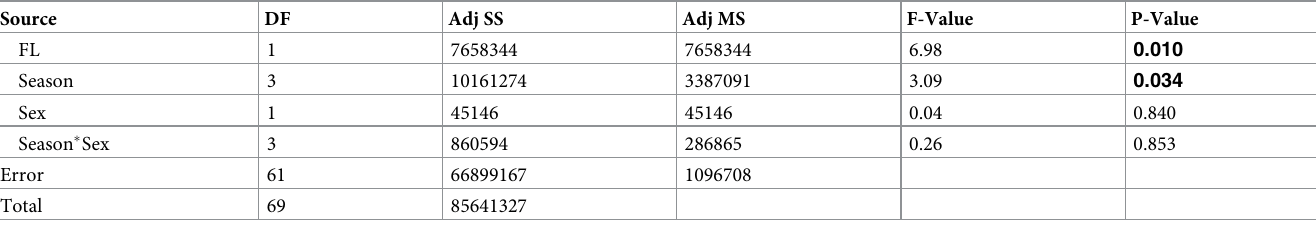
Table 3. General linear model results on maximum underlying depth used by sharks.